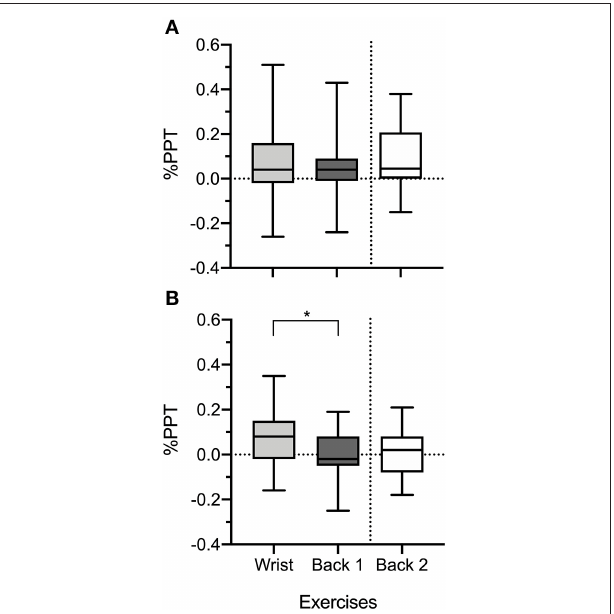
FIGURE 2 | Percentage of change of pressure pain thresholds (%PPT) at local (A) and remote (B) sites following wrist exercise and back exercises for studies 1 and 2. * p < 0.05.